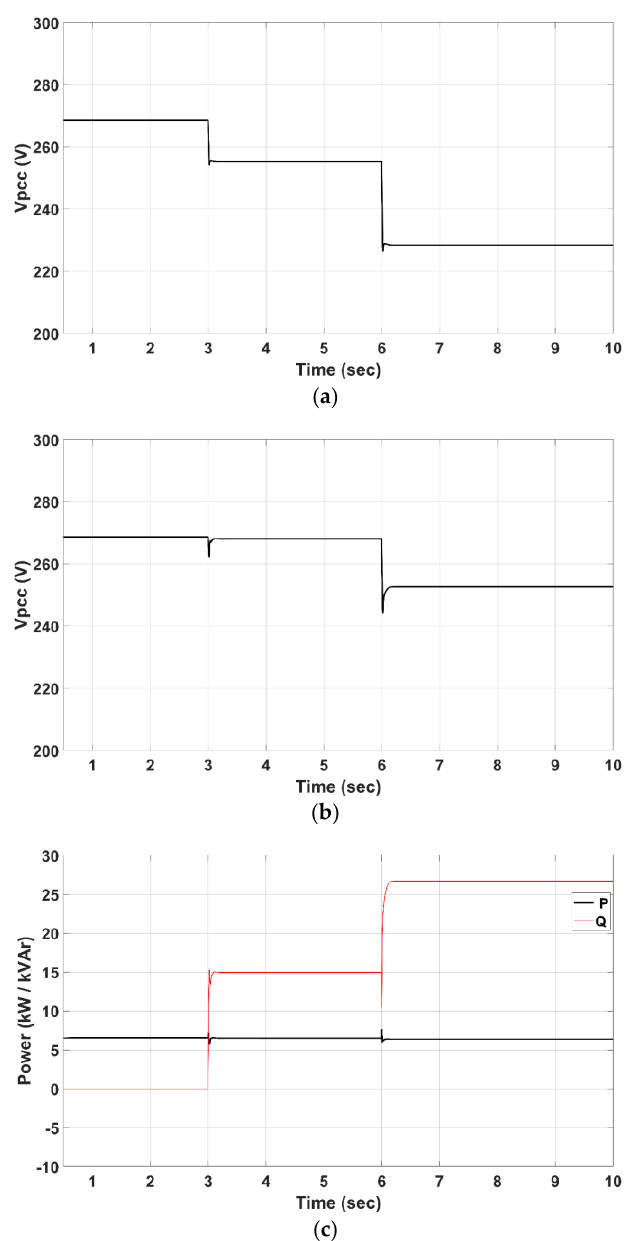
Figure 10. ( a ) The V pcc voltage without voltage regulation. ( b ) The V pcc voltage when the reactive power support is activated. ( c ) The transferred power through the inverter.